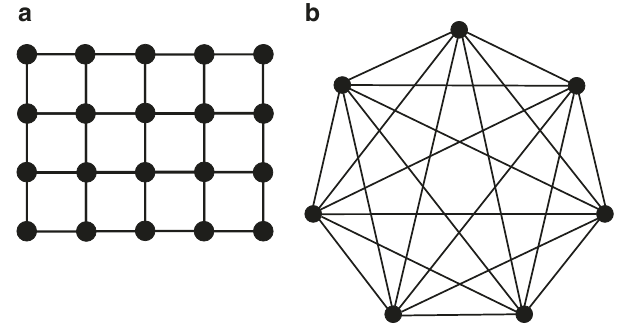
Fig. 1 Graphical maps with different node connectivity. a Locally connected graph. b Fully connected